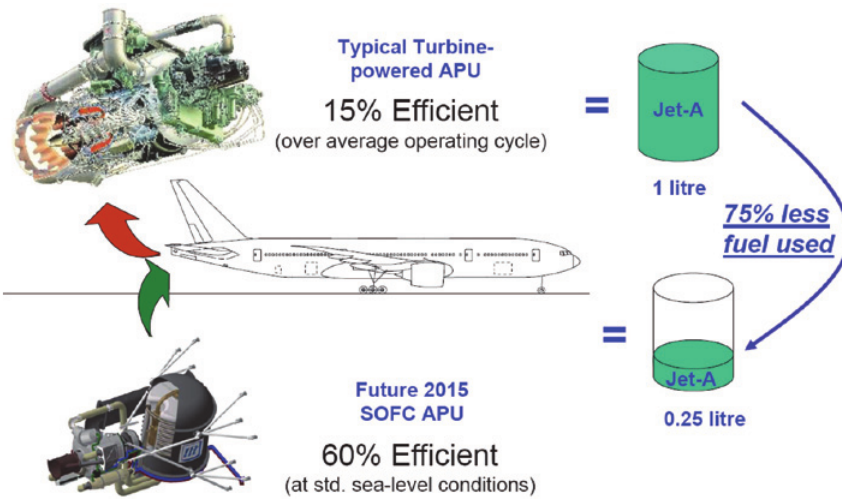
Fig. 8. Boeing – fuel saving on the ground